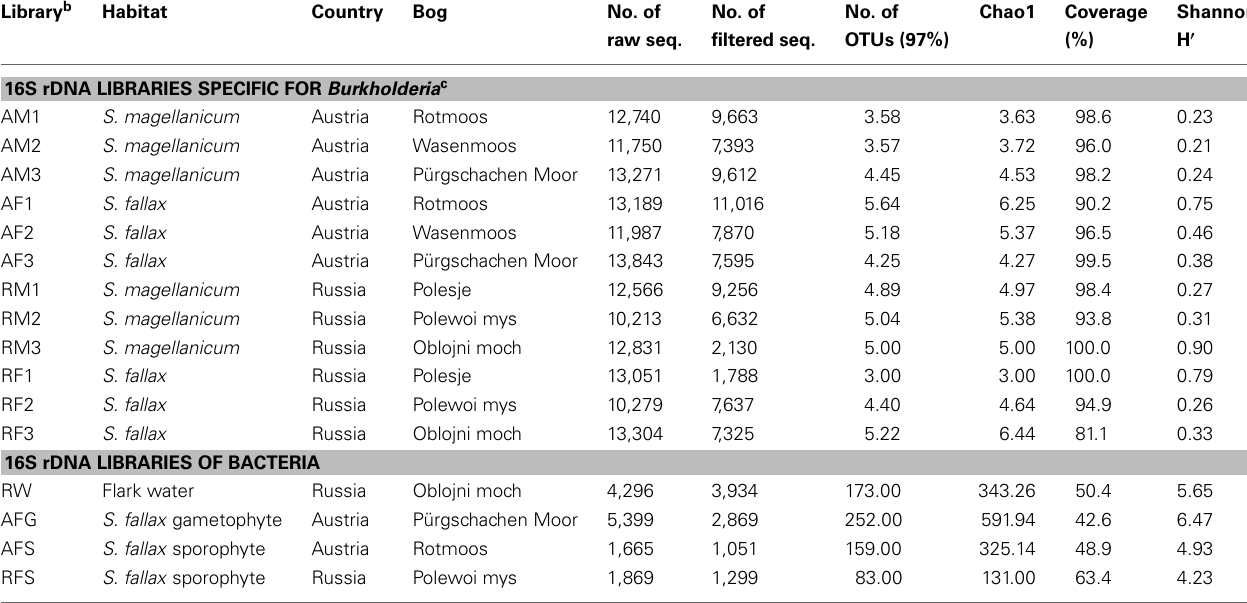
Table 2 | Description and alpha-diversity estimation of the 16S rDNA pyrosequencing libraries of Sphagnum samples a . Library b